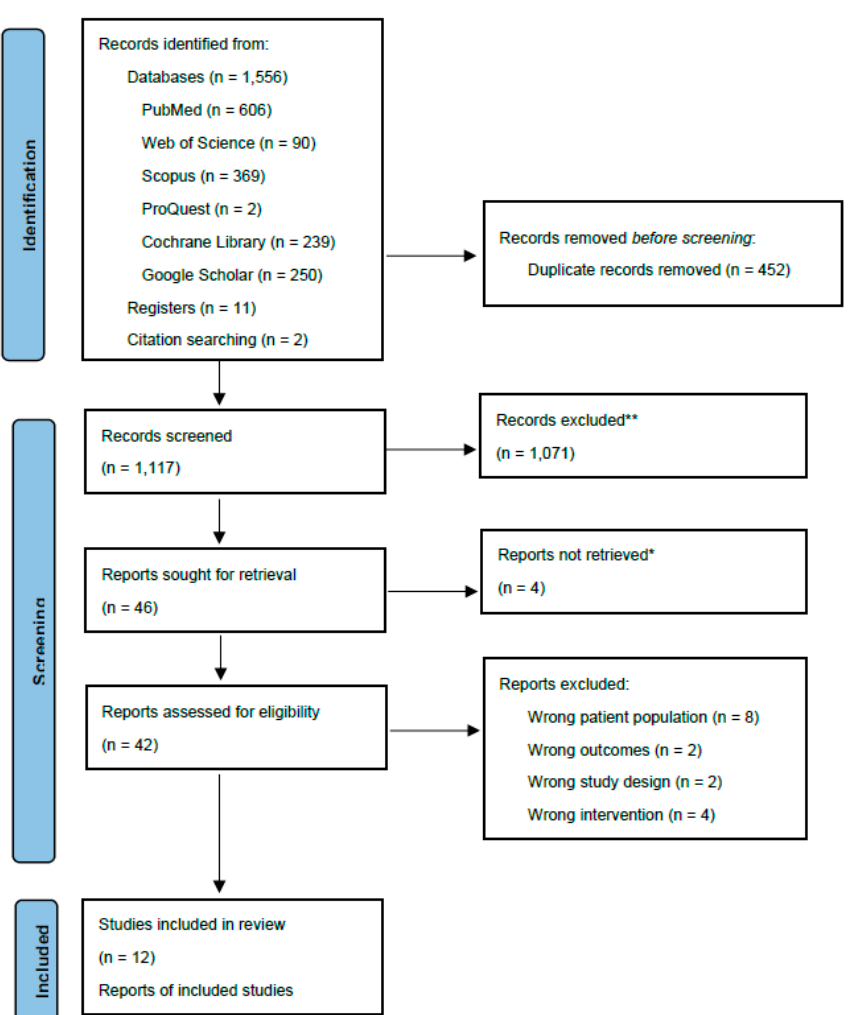
Figure 1. PRISMA flow chart for study selection. * Reports not retrieved refer to abstract-only records. ** Records excluded.